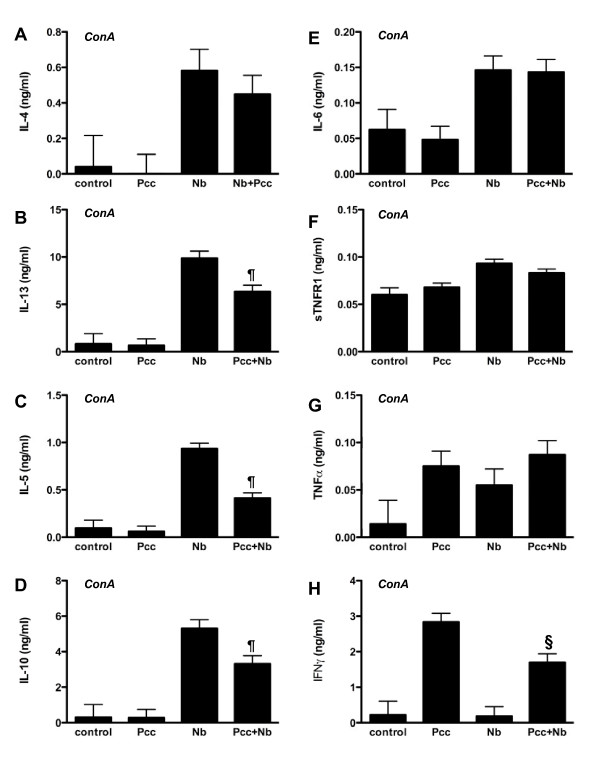
ConA-induced cytokine release in TLN lymphocyte recall assays. Cytokine concentrations in supernatants of ConA-stimulated TLN cells harvested at day 7 pi were measured with cytometric bead arrays. Groups did not differ in cytokine production at 3 or 5 days pi, and no antigen-specific responses were detected until 20 days pi. Data on day 7 pi IL-4 (A), IL-13 (B), IL-5 (C), IL-10 (D), IL-6 (E), sTNFR1 (F), TNF-α (G), and IFN-γ (H) production are shown. In these data, statistically significant down-regulatory effects of co-infection (Nb+Pcc) were found for IL-13 (P = 0.011), IL-5 (P = 0.0001), IL-10 (P = 0.007), and IFN-γ (P = 0.006), compared to relevant single-infection groups. Bars indicate mean ± SEM from 3 combined experiments, each with 4-9 mice per group. The symbol ¶ indicates significance of the difference between co-infected and Nb mice, while § indicates significance of the difference between co-infected and Pcc mice (P values included above and in Results text).